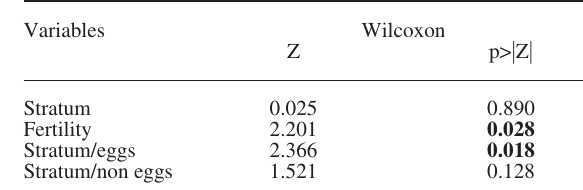
Table 4. – Results of the Wilcoxon ranked-sums test for the abun- dance of Sagitta tasmanica . Situations: Stratum (abundance at 0-50 m vs 50-200 m depth), Fertility (individuals with eggs vs without eggs), Stratum/eggs (individuals with eggs at 0-50 m vs 50-200 m), and Stratum/non eggs (individuals without eggs at 0-50 m vs 50-200 m). Significant values are in bold ( α = 0.05).